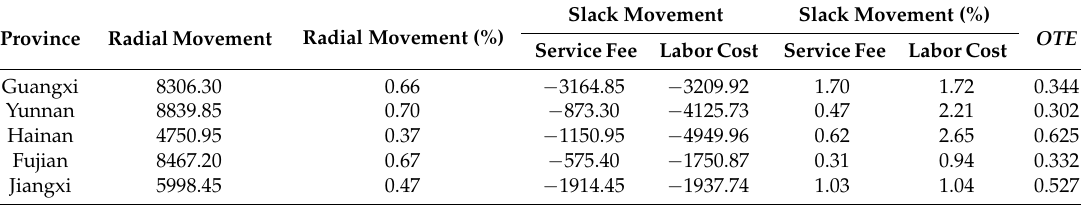
Table 6. Five province cassava-production efficiency DEA improvement in